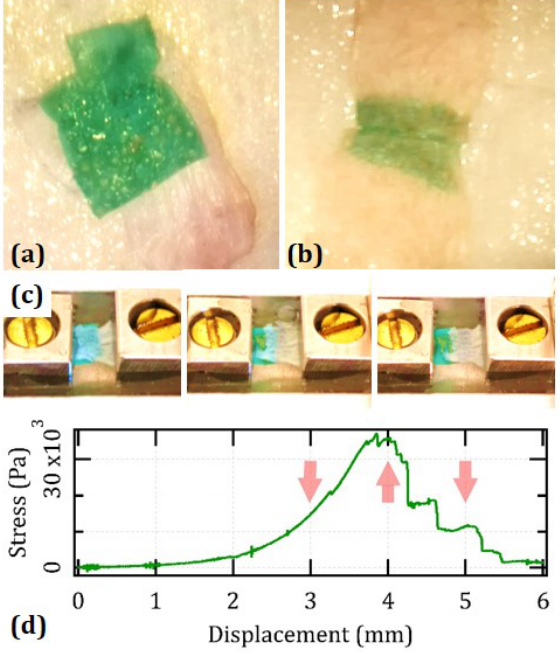
Figure 3. Laser bonding to biological tissue and its mechanical strength: Photographs of films welded to a segment of rabbit tendon ( a ) and a simulated wound in human skin ( b ). The irradiated spots look clearer than their neighborhood probably due to the photobleaching of ICG and an ultrastructural modification of the mats. ( c ) Snapshots taken during a measuring run in the case of shear testing of the adhesion between a sample and a piece of rabbit tendon. ( d ) Relevant stress–strain curve calculated by normalizing by the total nominal surface area of the 20 spots. The arrows roughly correspond to the snapshots reported in panel ( c ) and illustrate that the breakdown of the seam occurs by the progressive failure of individual spots one by one or in small